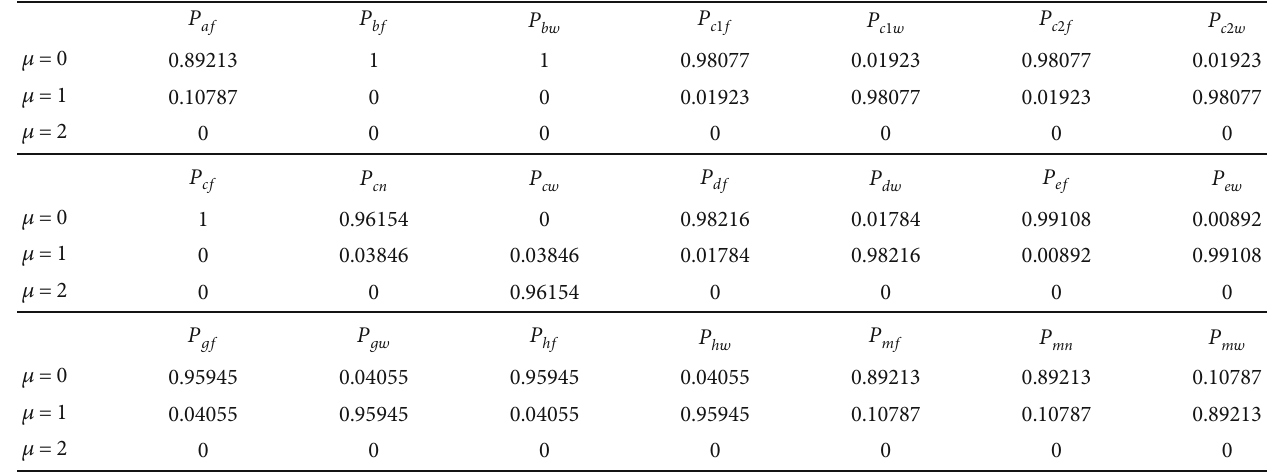
Table 8: Token probability